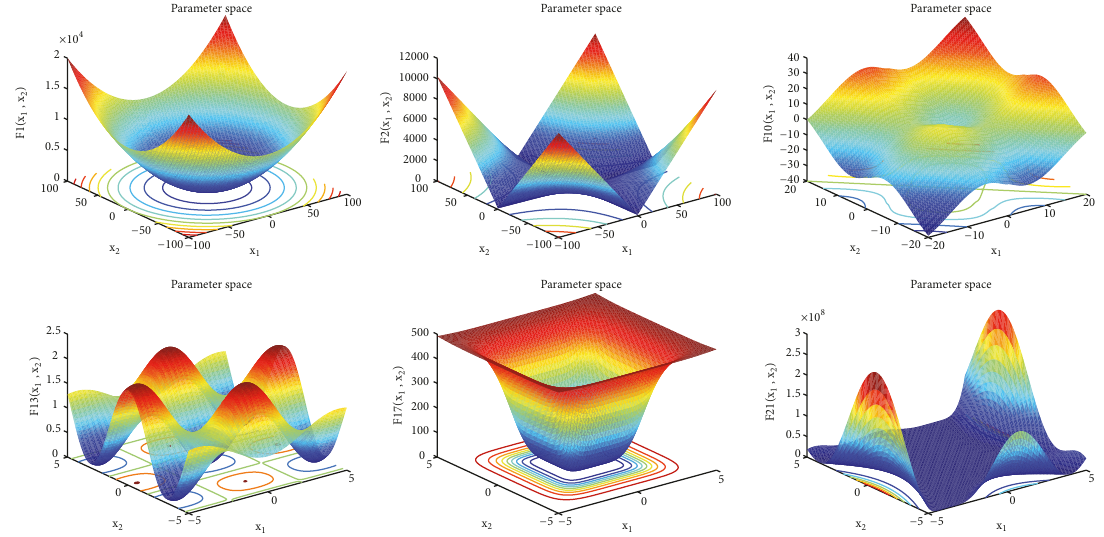
Figure 2: 2D version of typical benchmark functions 𝐹 1 , 𝐹 2 ,𝐹 10 , 𝐹 13 , 𝐹 17 ,𝐹 21